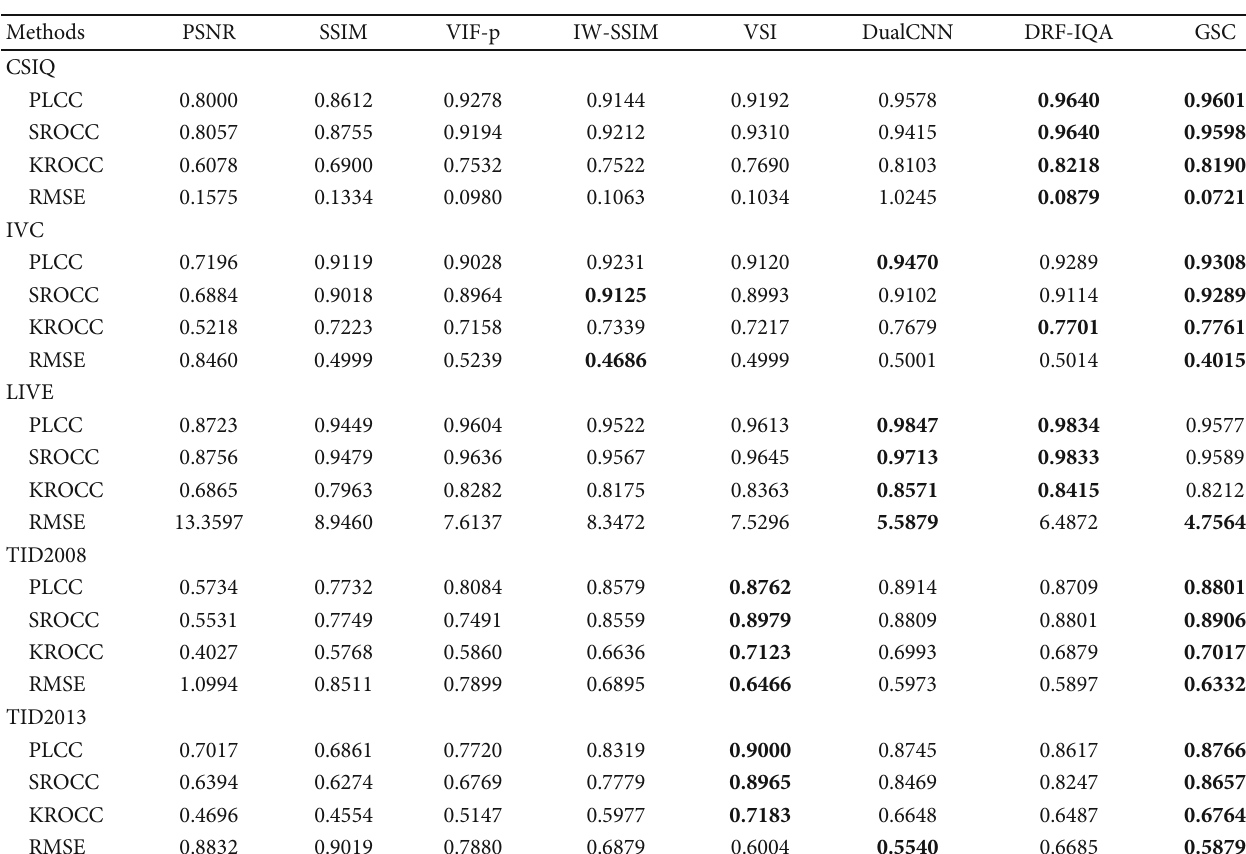
Table 2: Comparison of the results of 8 IQMs in 5 classic